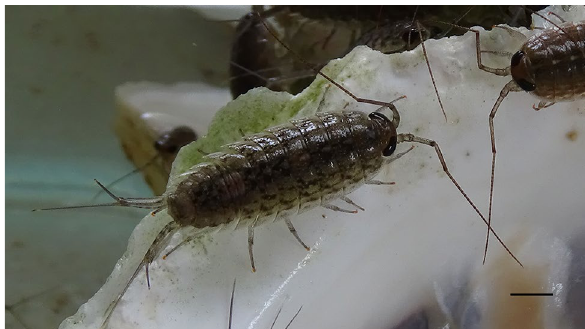
Figure 1. External morphology of Ligia exotica (scale bar = 0.6